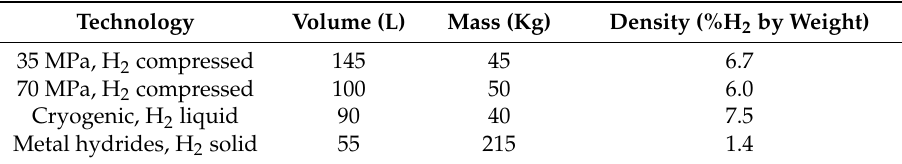
Table 4. Characteristics of Hydrogen storage